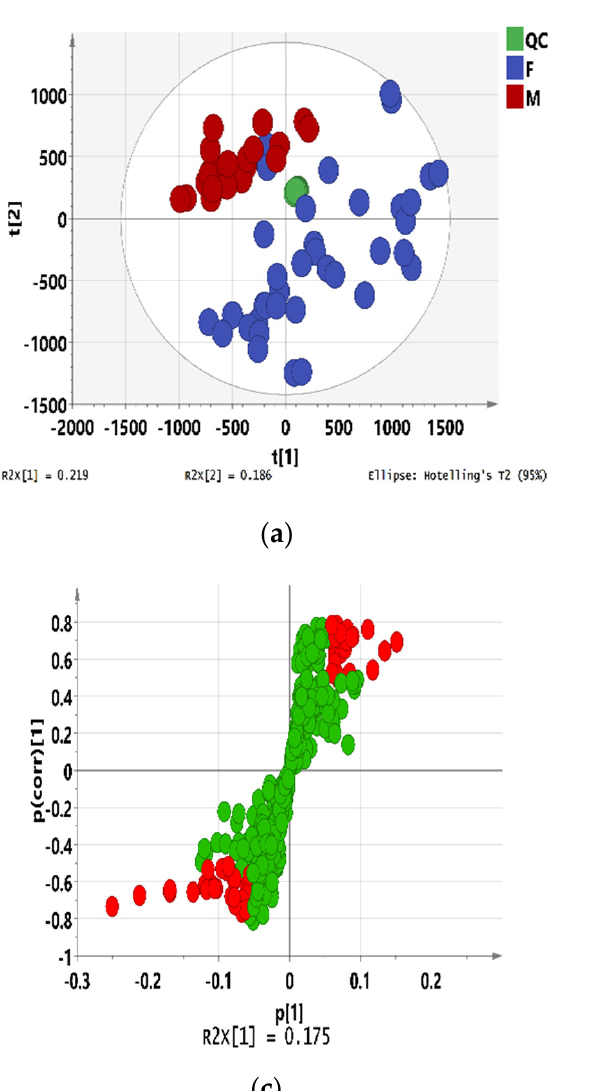
* n neutral molecular weight calculated according to adduct ion forms; # confirmed with the MS and MS/MS spectra of reference standard; * confirmed with the mass error (ME), fragmentation score (FS), isotopic similarity (IS), and score of matched with an in-house library. Compound B1 yielded the parent ion at m/z 173.1038 [M − H] − and was identified as arginine according to the literature [48]. Compound B2 displayed the parent ion at m/z 503.1606 [M − H] − and fragment ions at m/z 221.0655, 179.0552, 161.0447, 113.0236, 89.0240, and 71.0135 and was identified as raffinose by comparing with those ions recorded in Massbank. For compound B3, the parent ion at m/z 403.1235 [M − H] − and fragment ions at m/z 191.0556 and 119.0315 were observed. After further comparison with the literature [49], compound B3 was identified as gardenoside. Compound B4 showed the parent ion at m/z 405.1161 [M − H] − and fragment ion at m/z 243.0649. It was identified as astringin by comparing the retention behavior, accurate molecular weight, and MS E fragments with